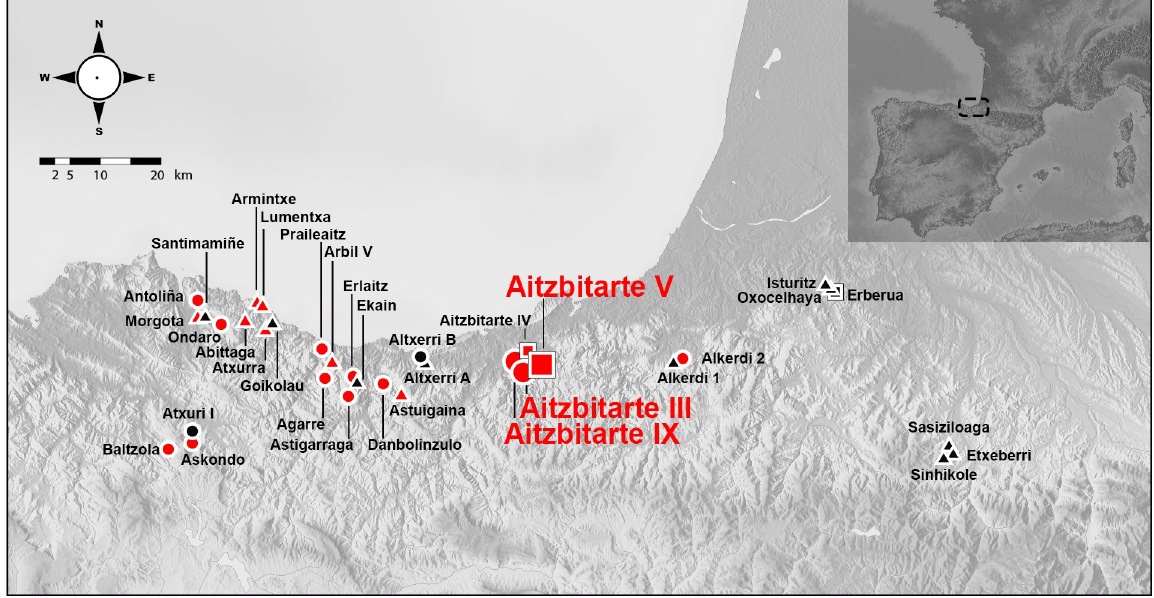
Fig 1. Decorated caves in Eastern Cantabrian Region (from Nervio´n to Bidasoa) and the Western Pyrenees (from Bidasoa to the Gaves de l’Adour) (base map: https://maps-for-free.com): Black discovered during the 20th century; red found in the 21st century; circle for pre- Magdalenian ensembles; triangle for Magdalenian ones; square for complex ensembles (pre-Magdalenian and Magdalenian).